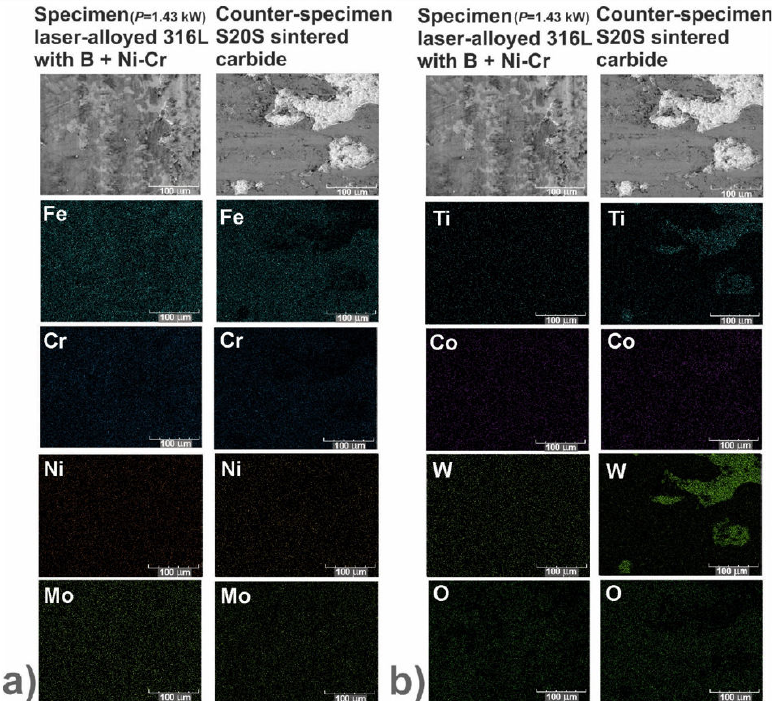
Figure 13. Worn surfaces of laser-alloyed specimen with boron, nickel and chromium using a dilution ratio of 0.43 ( P = 1.43 kW) and counter-specimen (S20S sintered carbide). ( a ) EDS patterns of the elements characteristic of the specimen as well as ( b ) the counter-specimen, taking into account oxygen concentration. Two-hour wear test with the change of counter-specimen at every 0.5 h.